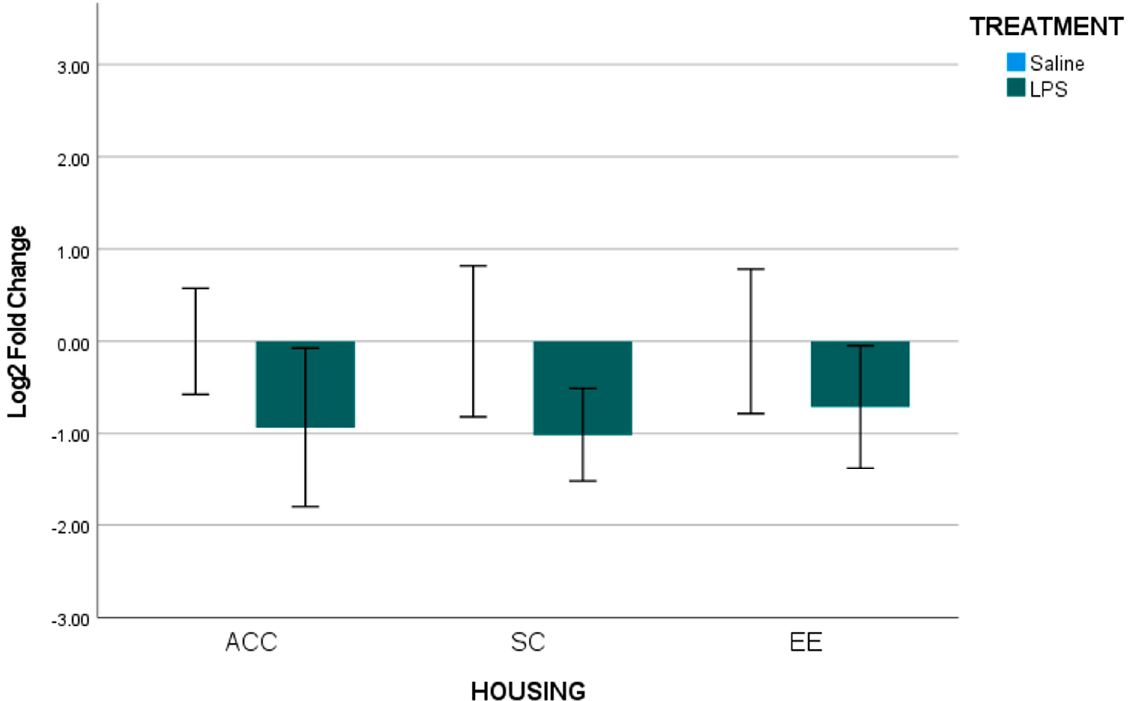
Figure 5. B2 SINE expression for Standard vs. Enriched and Standard vs. Social Control Housing in the Dorsal Hippocampus. Standard (Saline: n = 12, LPS: n = 10), Enriched (Saline: n = 12, LPS: n = 14), Social Control (Saline: n = 13, LPS: n = 14). A two-way ANOVA revealed there were no simple main effects from housing or treatment. There were no statistically significant interactions. (* p ≤ 0.05, a p < 0.05, main e ff ect of treatment, b p < 0.05, main e ff ect of housing; mean ± SEM).